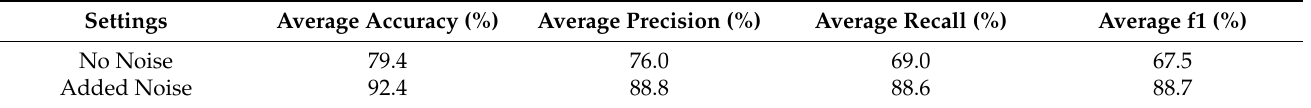
Table 3. Effect of adding Gaussian noise on the accuracy of the neural